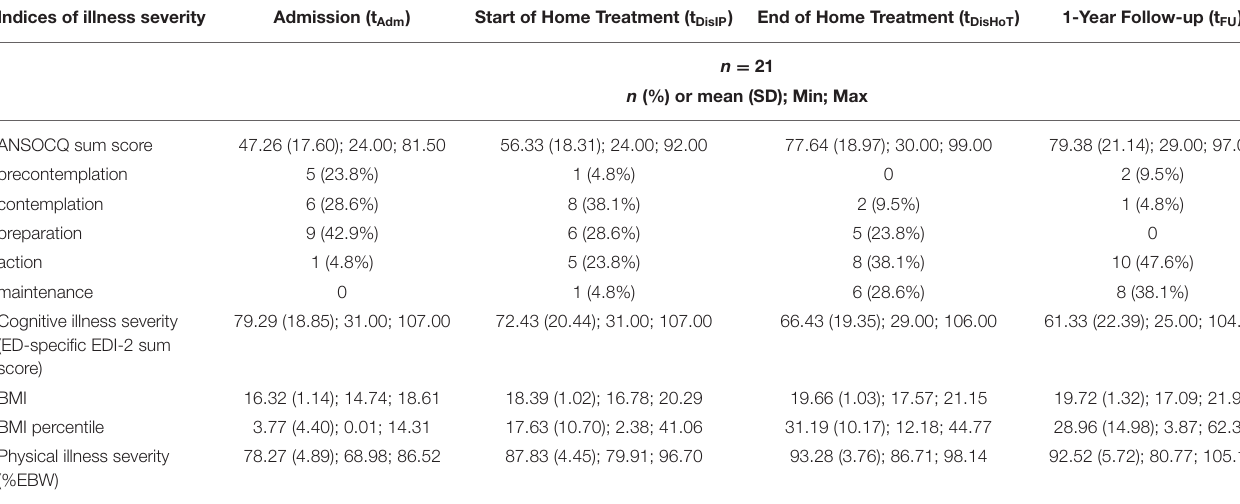
TABLE 2 | Development of patients’ motivation to change, cognitive ED illness severity (EDI-2), BMI and BMI-percentile, and physical illness severity (%EBW) at the beginning of each treatment phase and at the one-year follow-up. Indices of illness severity